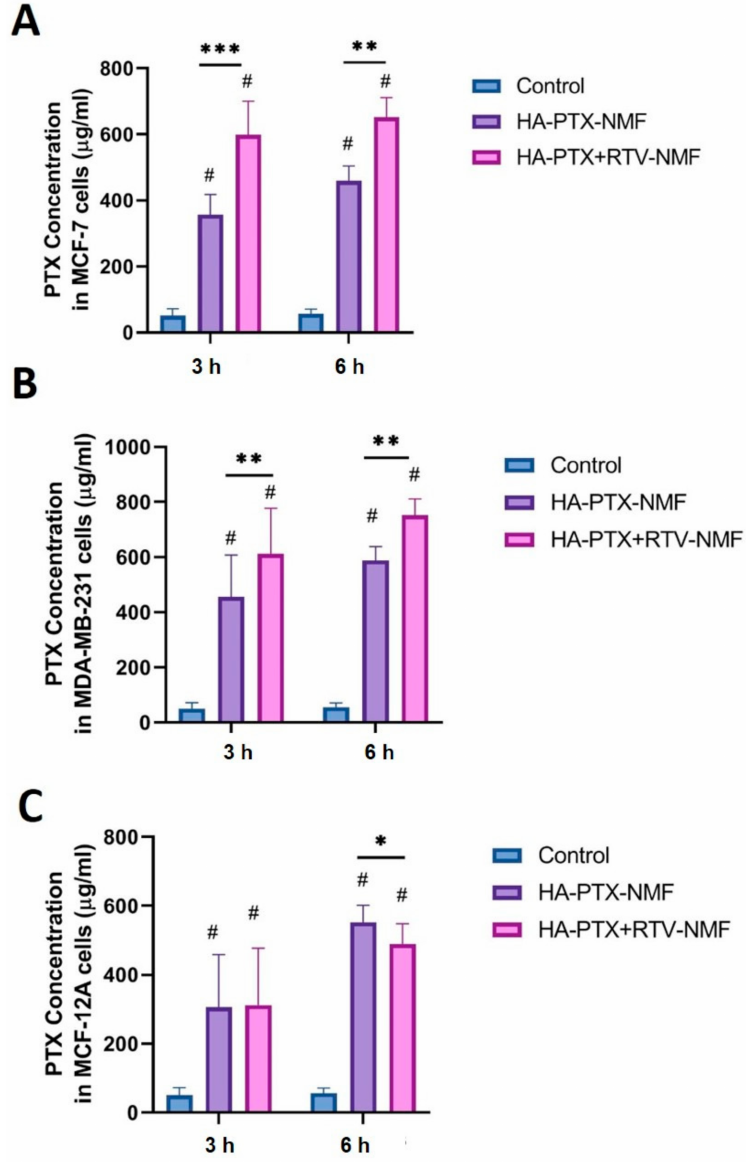
Figure 12. Intracellular accumulation of PTX in ( A ) MCF-7 and ( B ) MDA-MB-231 ( C ) MCF-12A cells at 6 and 12 h after treatment with HA − PTX + RTV − NMF and HA − PTX − NMF at 6 and 12 h using UHPLC-MS method of PTX quantification. The data were expressed as mean ± SD ( n = 3). (# = significant difference as compared to control group and * p ≤ 0.05, ** p ≤ 0.01, ns = not significant, *** p ≤ 0.001 as compared to PTX + RTV − NMF